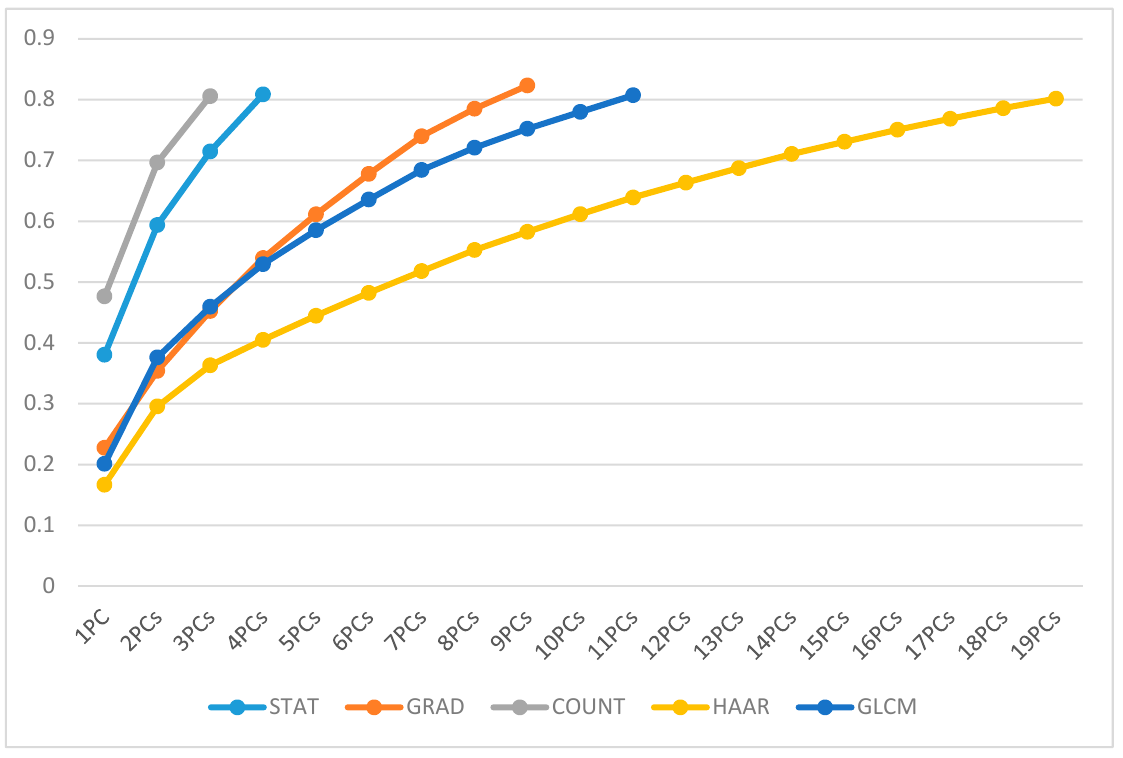
Figure 5. Overview of PC’s cumulative variance for each feature set.